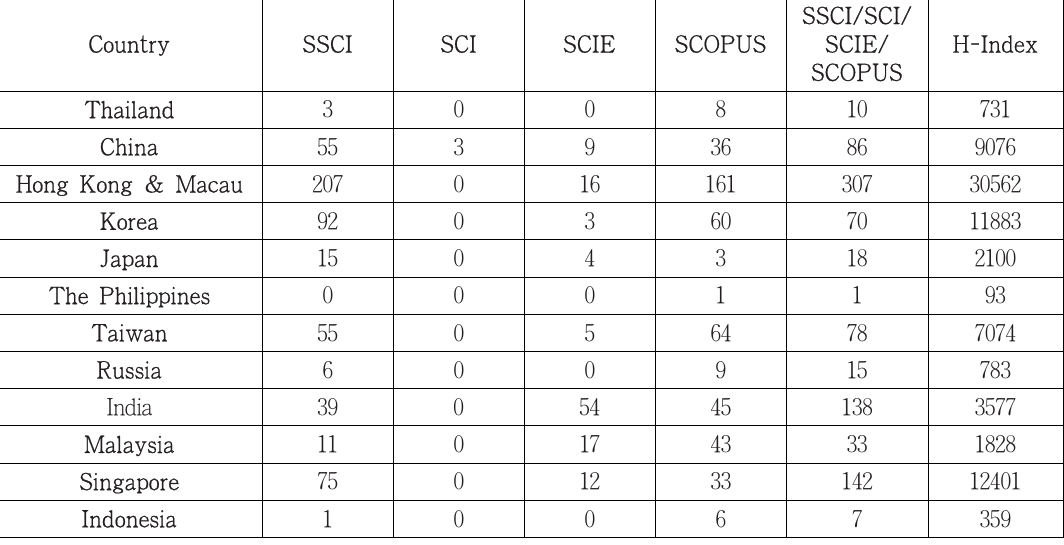
<Table 3> Summary of Academic Performances by